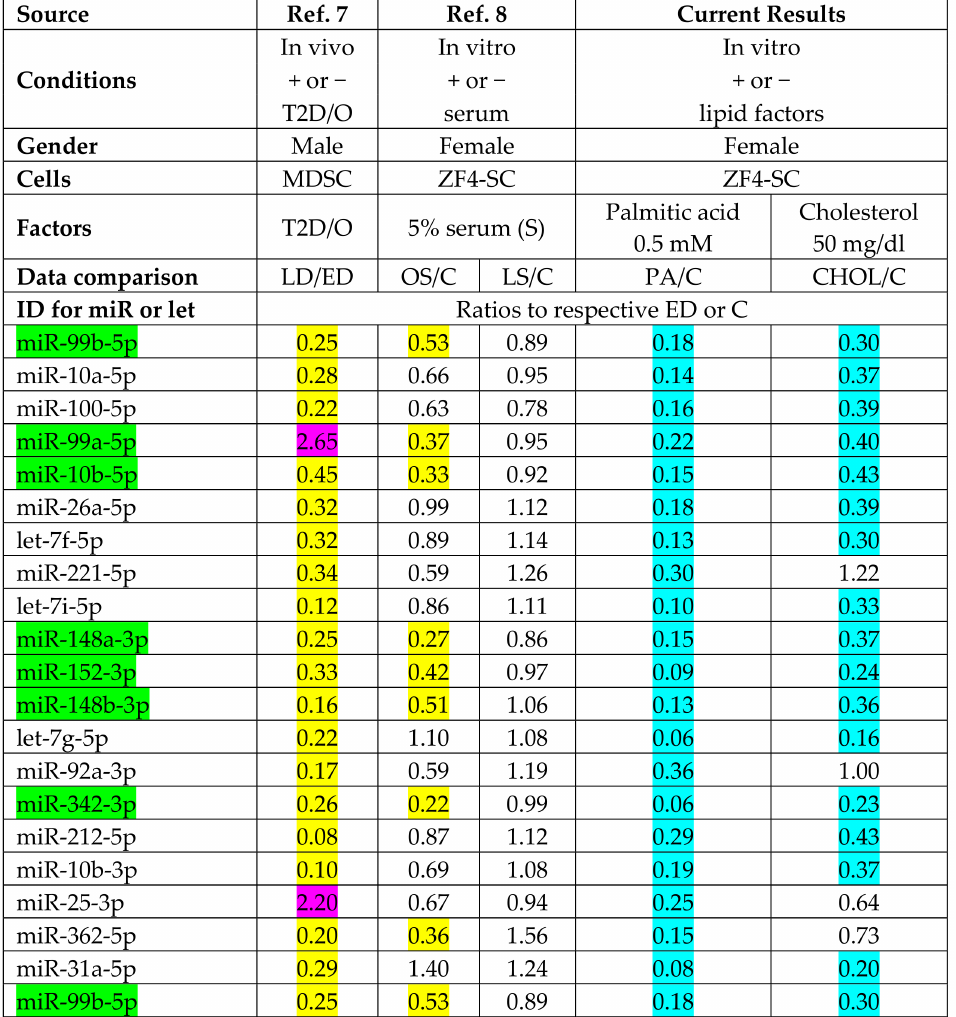
Table 2. A similar decrease of key miRs unrelated to myostatin by lipid factors was found in ZF4-SC. See Table 1 for the legend explanation, except that here the selected miRs were unrelated to myostatin. Within those selected miRs were the ones most expressed and changed by incubation as reported previously [8]. Purple highlighting shows the only two in vivo, which within the selected miRs were